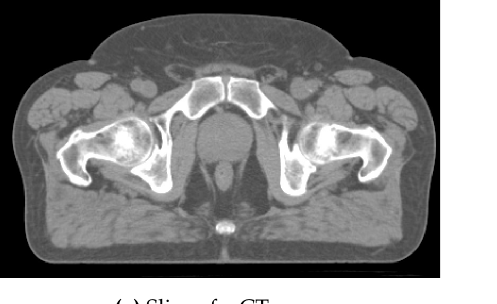
Figure 1. Comparison of CT and CBCT